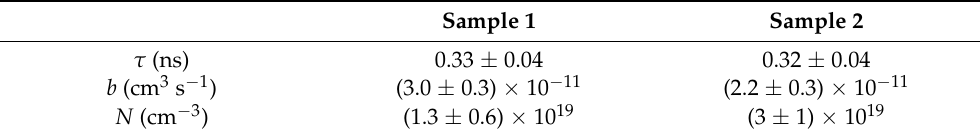
Table 1. Recombination parameters and equilibrium free carrier density extracted by the data